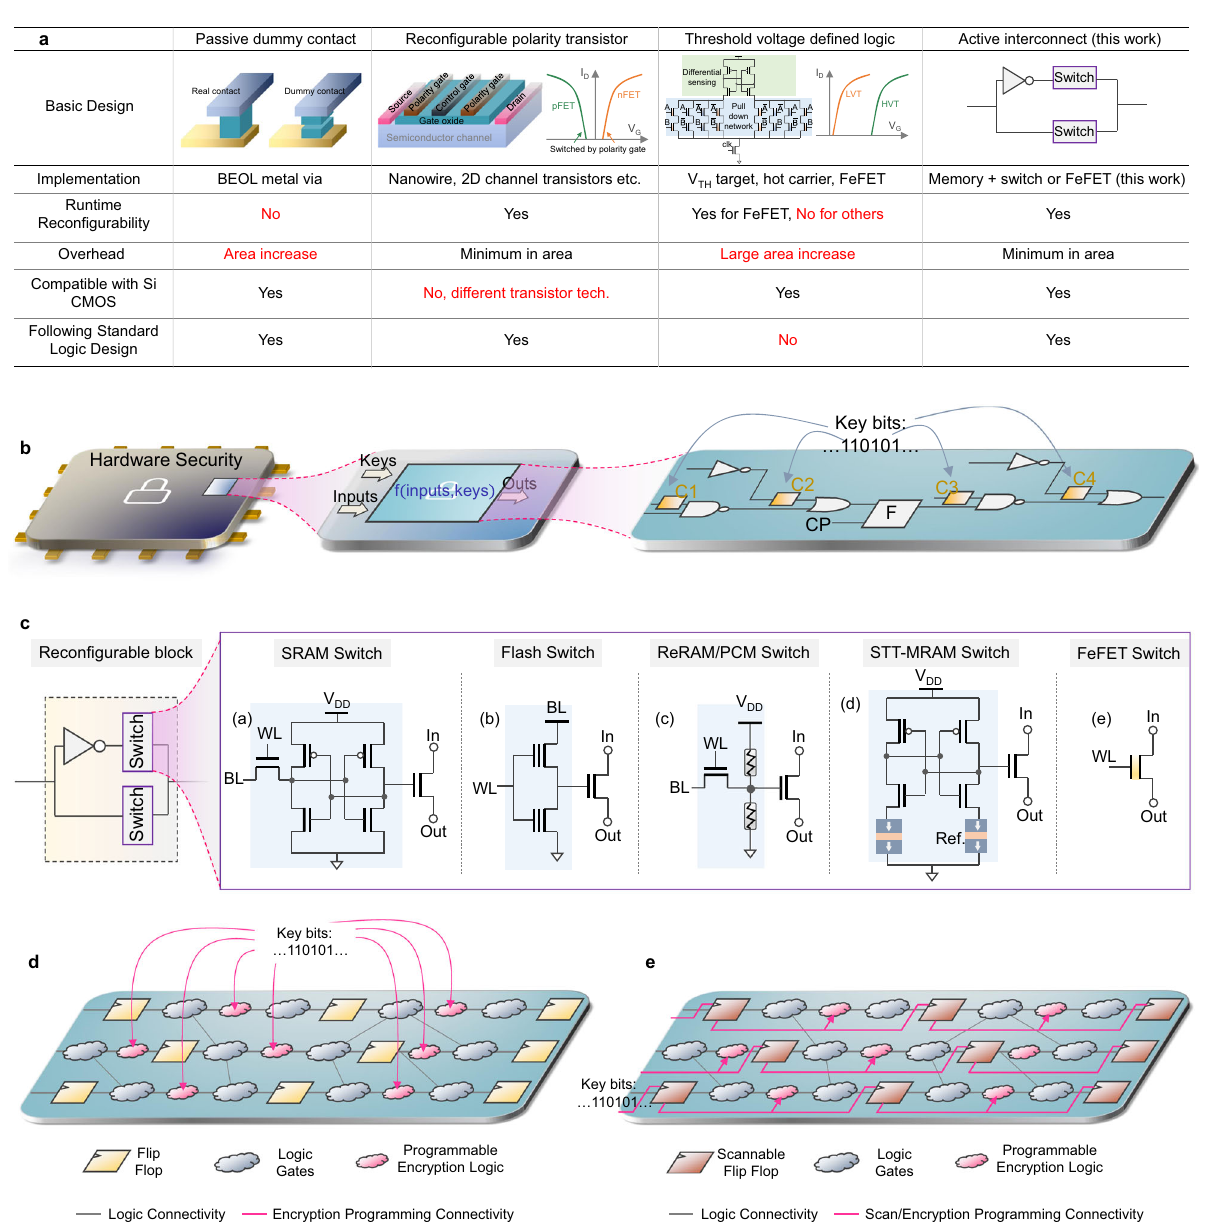
Fig. 1 Overview of the proposed encryption of IC logic design harnessing the ultra-compact FeFET active interconnect recon fi gurable switch. a Comparison between different camou fl age logic designs. The proposed active interconnect based approach is advantageous in realizing the camou fl age logic. b Illustration of utilizing the active interconnect based encryption block for obfuscating the IC logic. The keys are to dynamically recon fi gure the interconnect such that the logic function is hidden. c The encryption block and implementations of switches using various technologies to